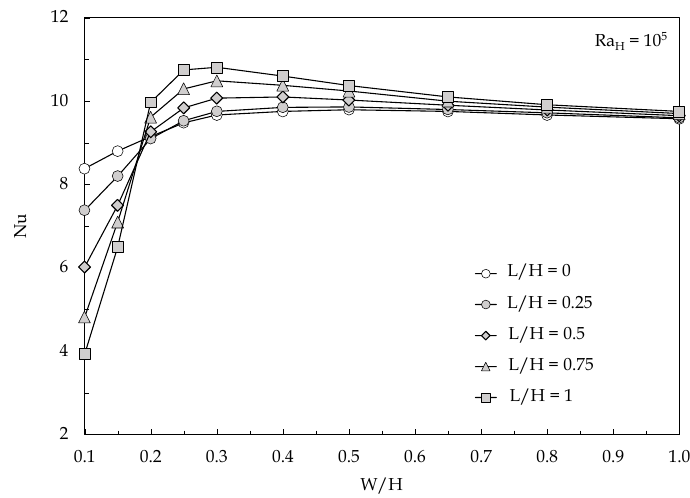
Figure 10. Nu vs. W / H for Ra H = 10 5 using L / H as the parameter.